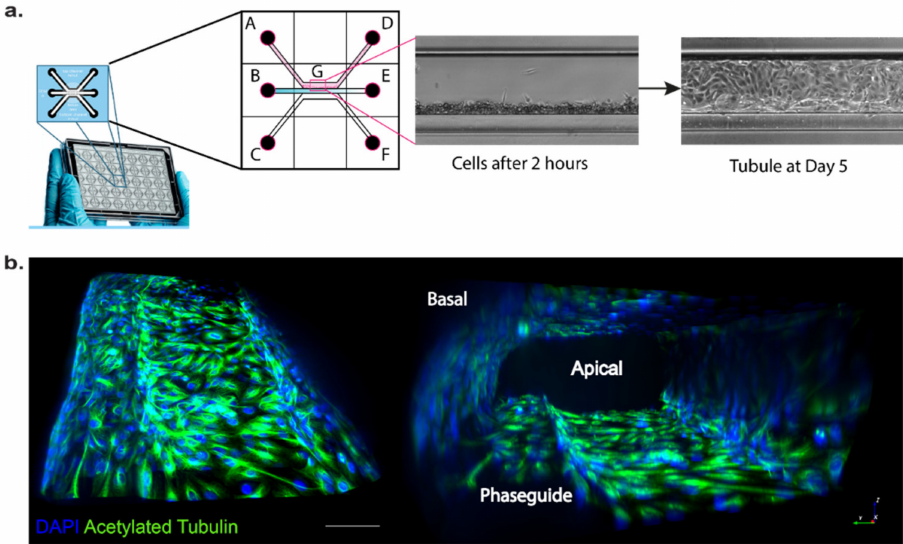
Figure 2. Proximal tubule on a chip: ( a ) 3-lane OrganoPlate ® with 40 chips, a pictorial representation of a single chip with all its wells (A: cell inlet, B: gel inlet, C: medium inlet, D: cells outlet, E: gel outlet, F: medium outlet and G: observation window). The observation window (G) with the top lane shows when cells adhere against the gel in the middle lane followed by cells forming a tubule at Day 5. ( b ) Immunostaining images of the 3D proximal tubule grown in OrganoPlate with acetylated tubulin (green); scale bar: 500 µ